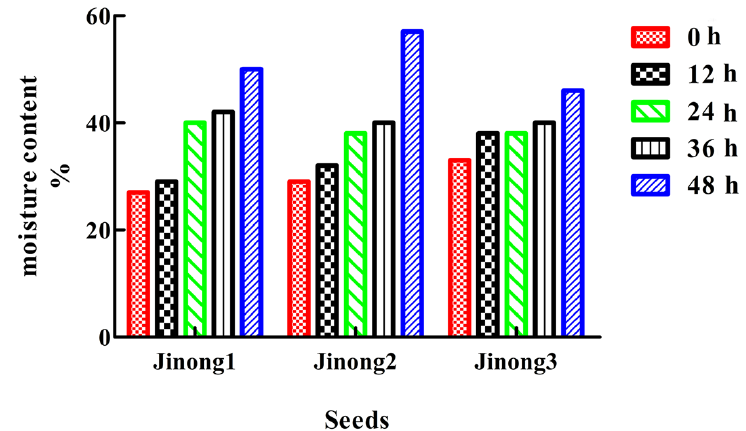
Figure 2. The changes in moisture content for different immersed time.